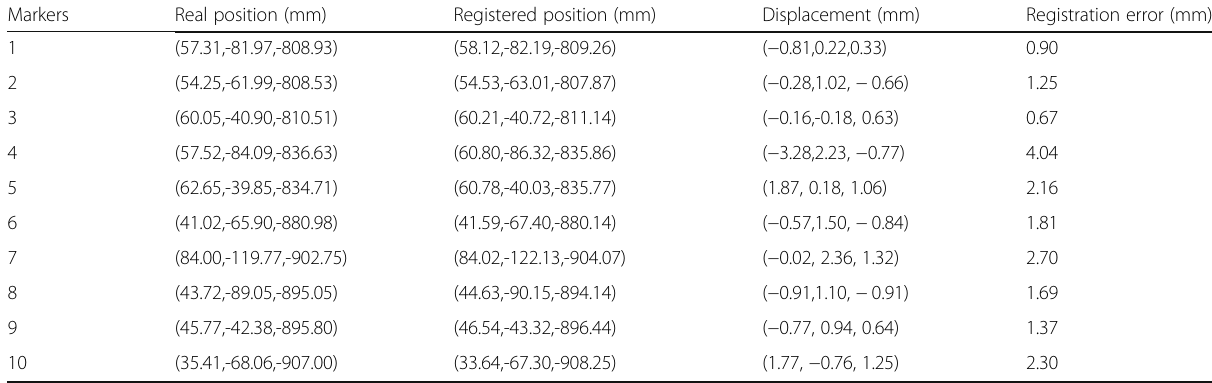
Table 1 Performance statistics of automatic registration